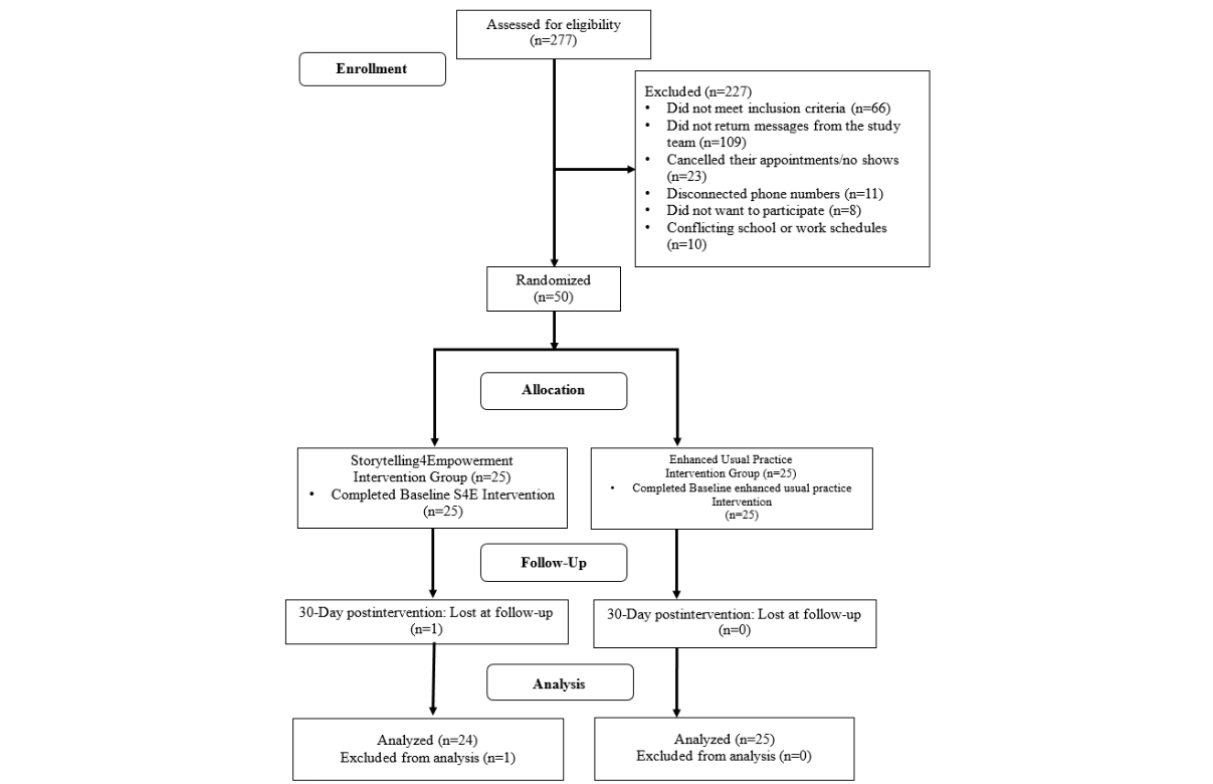
Figure 1. Consolidated Standards of Reporting Trials